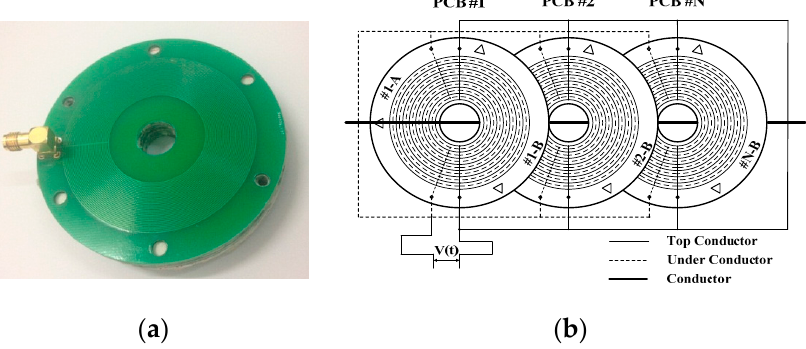
Figure 9. Design of non-contact voltage sensor: ( a ) physical design of the sensor and ( b ) schematic diagram for sensor structure. diagram for sensor